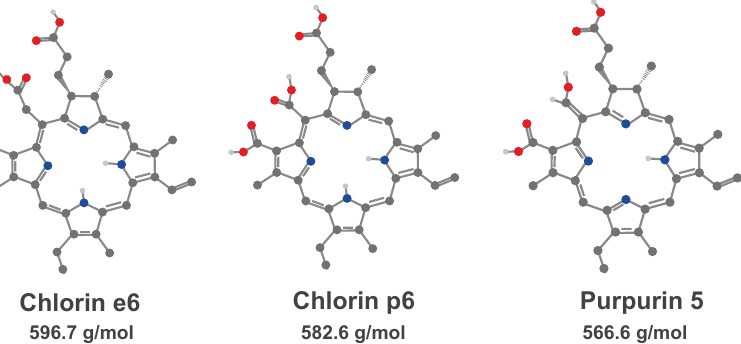
Figure 1. Molecular structure of chlorin e6, chlorin p6 and purpurin 5. Molecular weights are indicated below each